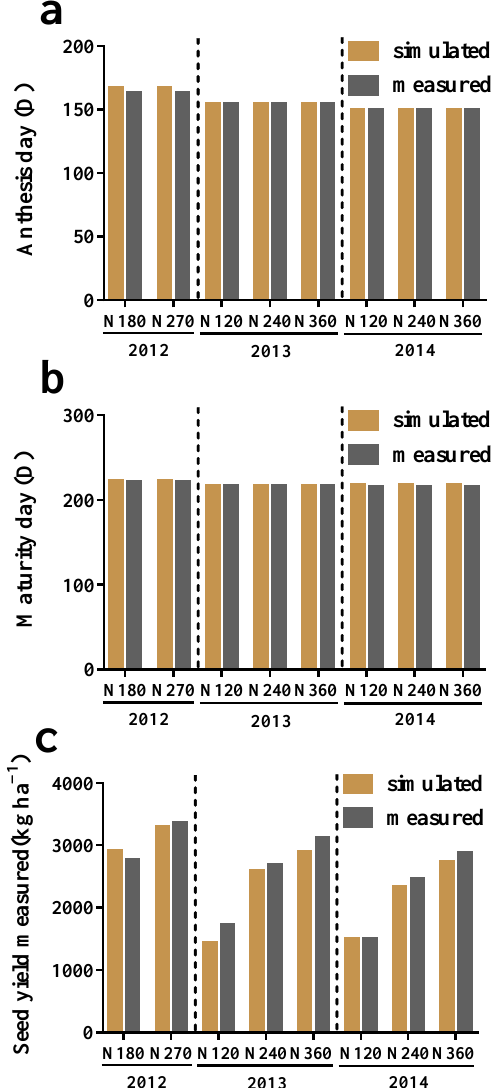
Figure 4. Measured and simulated anthesis day ( a ), maturity day ( b ) and yield ( c ) of Huayouza62 under different nitrogen rates.